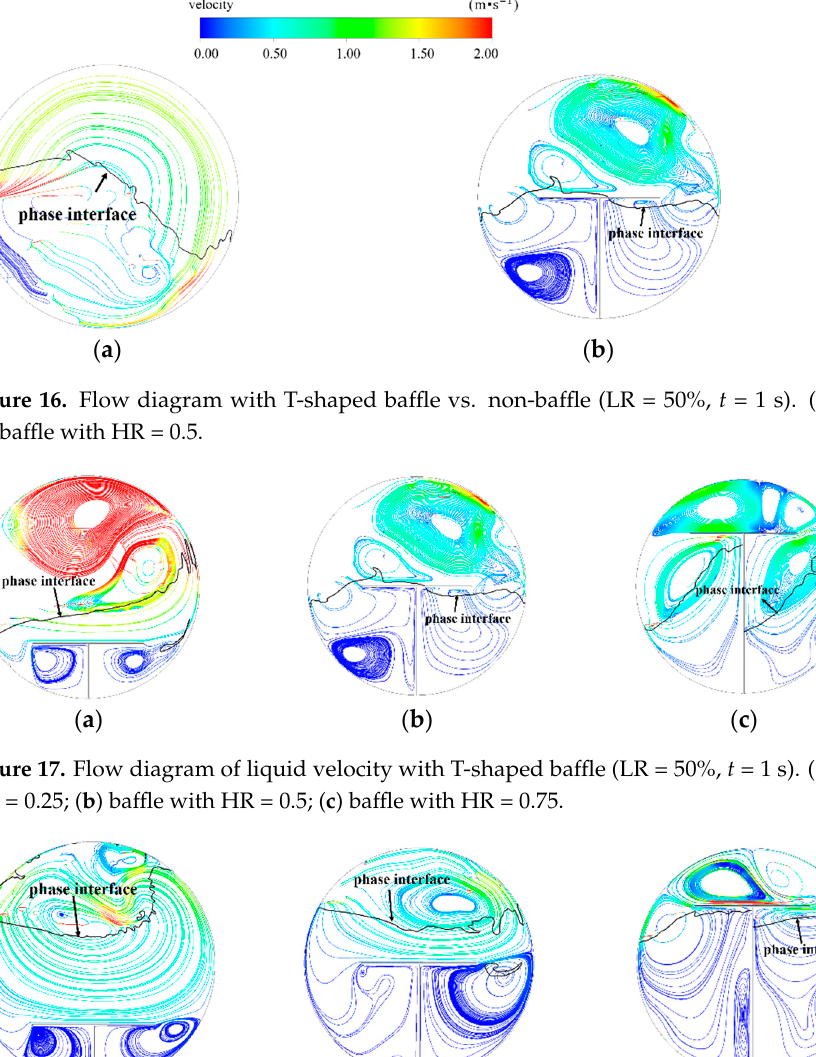
Figure 17. Flow diagram of liquid velocity with T-shaped baffle (LR = 50%, t = 1 s). ( a ) baffle with HR = 0.25; ( b ) baffle with HR = 0.5; ( c ) baffle with HR = 0.75.